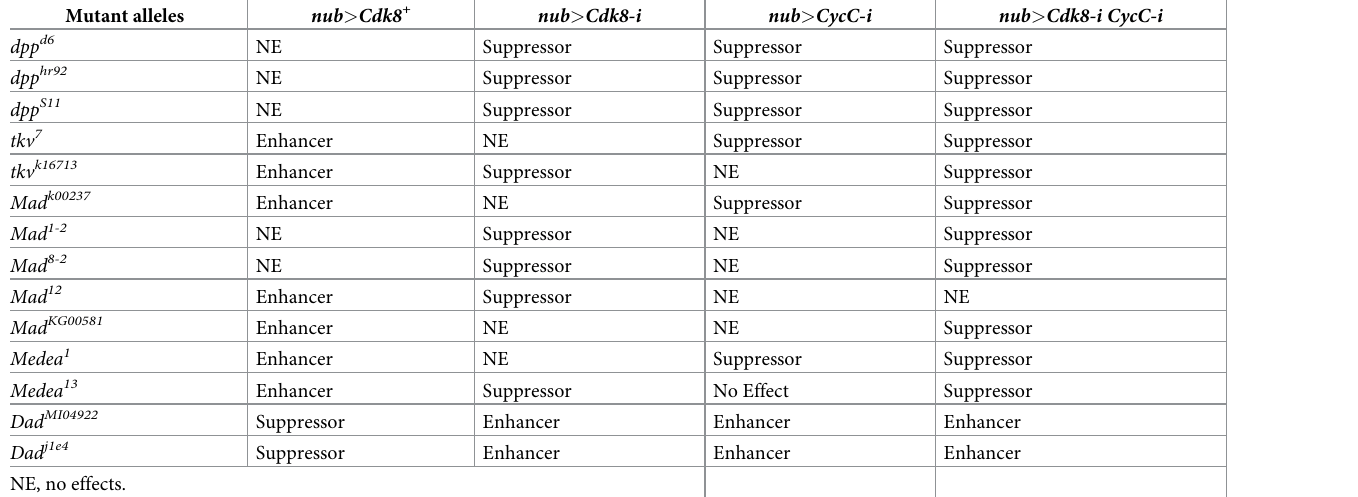
Table 2. Mutant alleles of genes encoding components of the Dpp signaling that modify the CDK8- or CycC-specific phenotypes. Mutant alleles nub > Cdk8